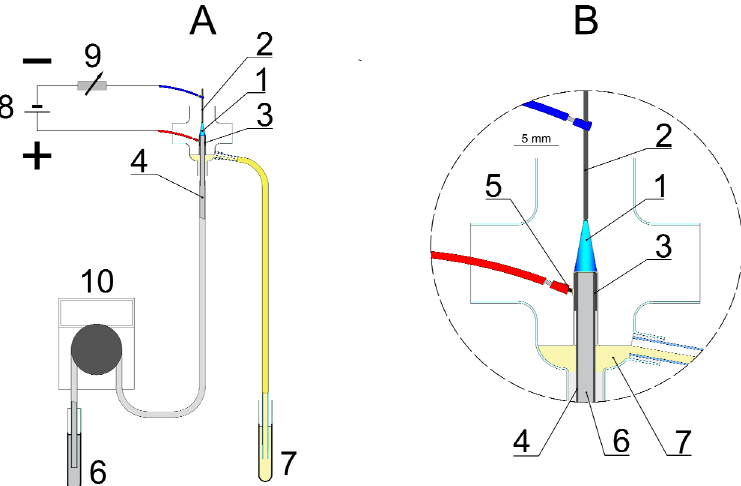
Figure 5. A scheme of the flowing liquid anode (FLA)-atmospheric pressure glow discharge (APGD) reaction-discharge system for the continuous-flow production of Ag nanostructures. 1—dc-APGD; 2—pin-type metallic cathode; 3—graphite tube; 4—quartz capillary; 5—platinum wire; 6—flowing liquid anode solution; 7—solution after the dc-APGD treatment; 8—dc-HV generator; 9—ballast resistor; 10—peristaltic pump. ( A ) reaction-discharge system for the continuous synthesis of Ag nanostructures; ( B ) enlarged reaction-discharge system in circle on the right.